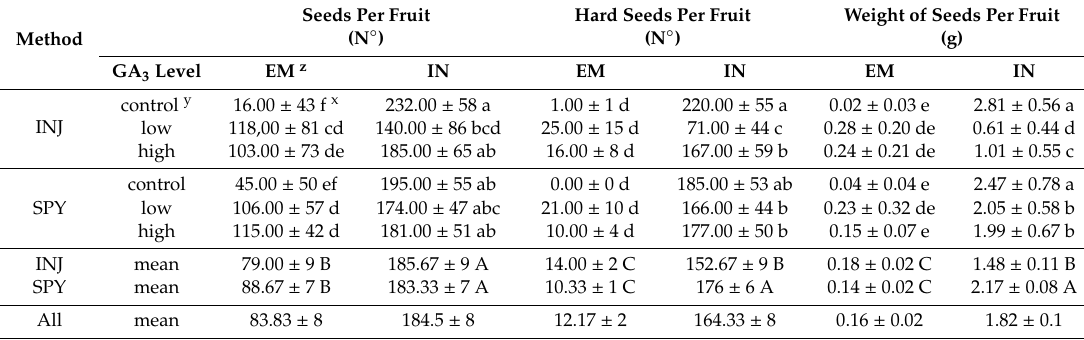
Table 3. E ff ect of GA 3 application treatments on seed